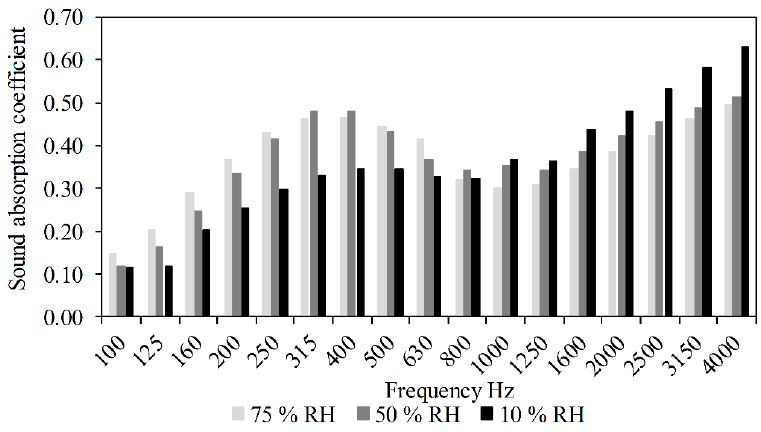
Figure 13. Sound absorption coefficient of S ‐ BP composite as a function of relative humidity.